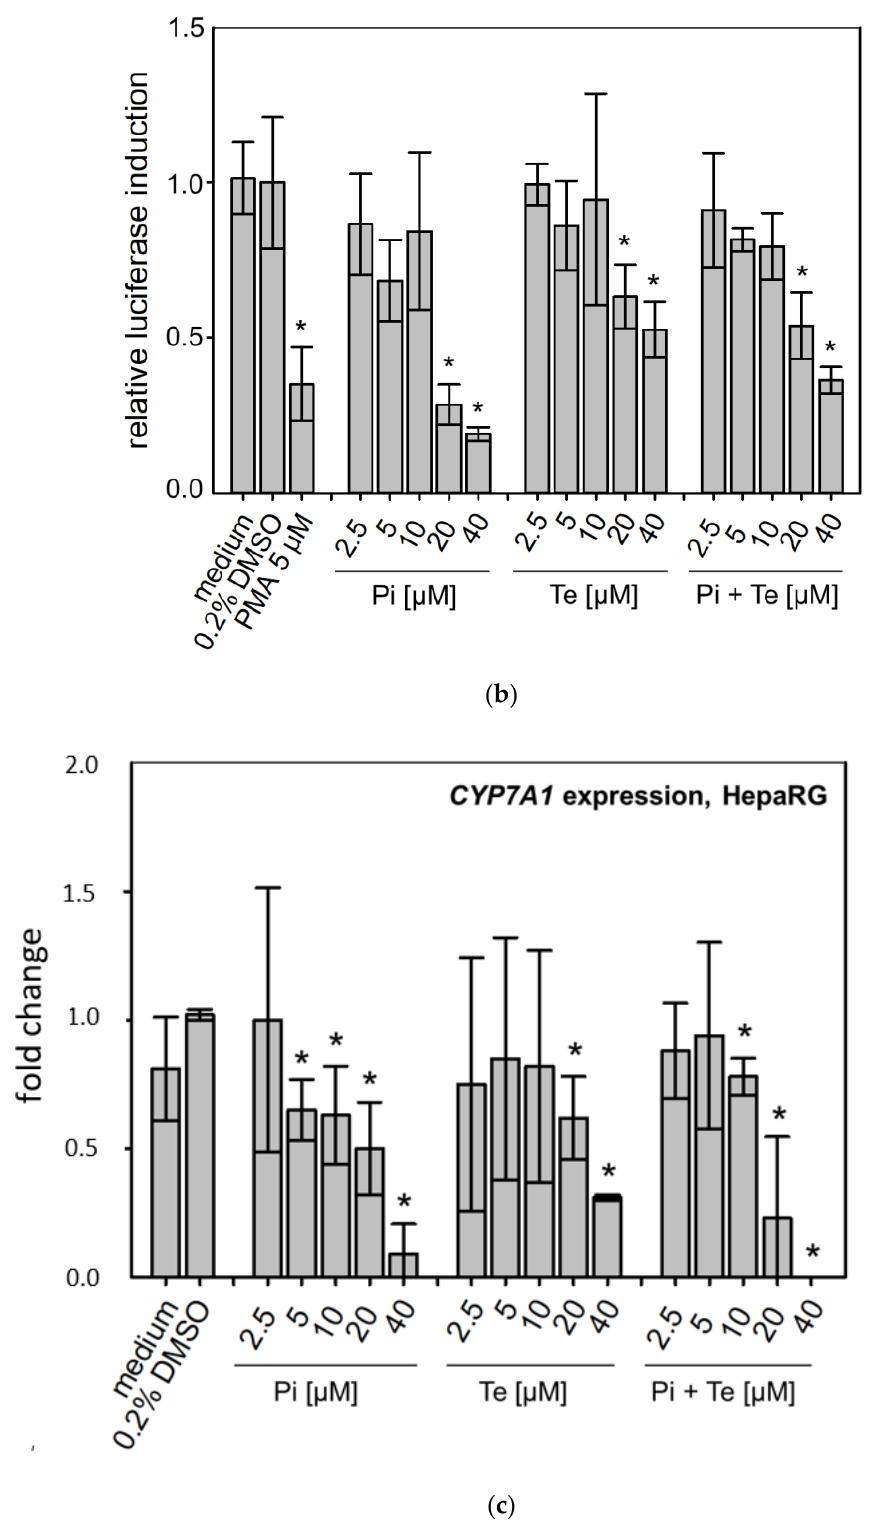
Figure 3. Effects of propiconazole (Pi) and tebuconazole (Te) on farnesoid-X-receptor (FXR) transcrip- tional activity and its target CYP7A1 . ( a ) Dual luciferase reporter transactivation assay for FXR in HepG2 cells, incubated with the test substances for 24 h. Relative induction of a luciferase-based reporter gene system based on a fusion protein of GAL4 with the ligand-binding domain of human FXR is shown after treatment with Pi, Te, and their equimolar combination from 2.5 µ M to 40 µ M. ( b ) CYP7A1 promoter assay in HepG2 cells. Activities of a luciferase-based reporter construct driven by a section of the promoter of the human CYP7A1 gene are shown as compared to solvent control after treatment with Pi, Te, and their equimolar combination from 2.5 μ M to 40 μ M for 24 h. ( c )